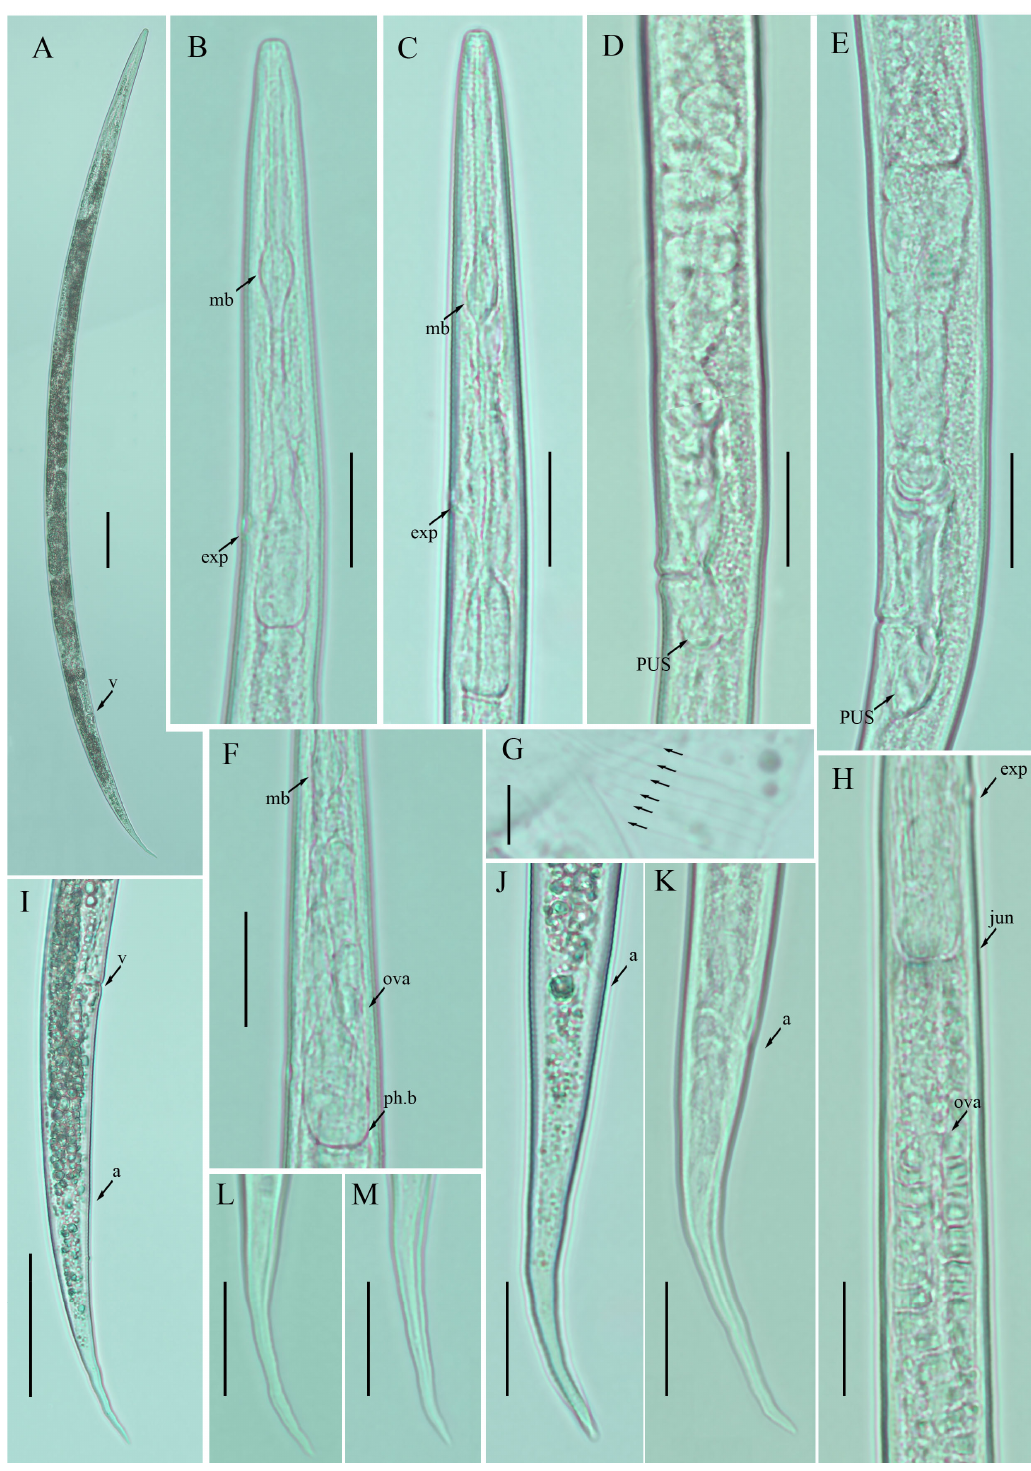
Figure 5. Photomicrographs of female Ditylenchus valveus Thorne and Malek [31] ( A ) Entire body; ( B , C ) pharyngeal region; ( D , E ) vulval regions; ( F ) posterior pharyngeal region; ( G ) lateral field lines; ( H ) post pharyngeal region showing reflexed ovary; ( I ) posterior body to tail terminus; ( J , K ) tail regions; ( L , M ) tail tips. Scale bars: ( A , I ) 50 µ m; ( B – F , H , J – M ) 20 µ m; ( G ) 5 µ m. Arrows: (a) anus; (exp) secretory–excretory pore; (ph.b) pharyngeal bulb; (jun) pharyngeal intestinal junction; (mb) median bulb; (ova) ovary; (PUS) postvulval uterine sac; (v) vulva.